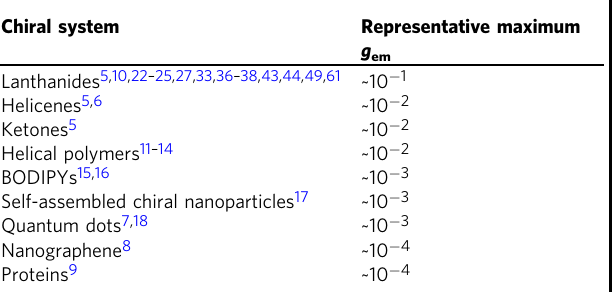
Table 1 Representative maximum g molecular